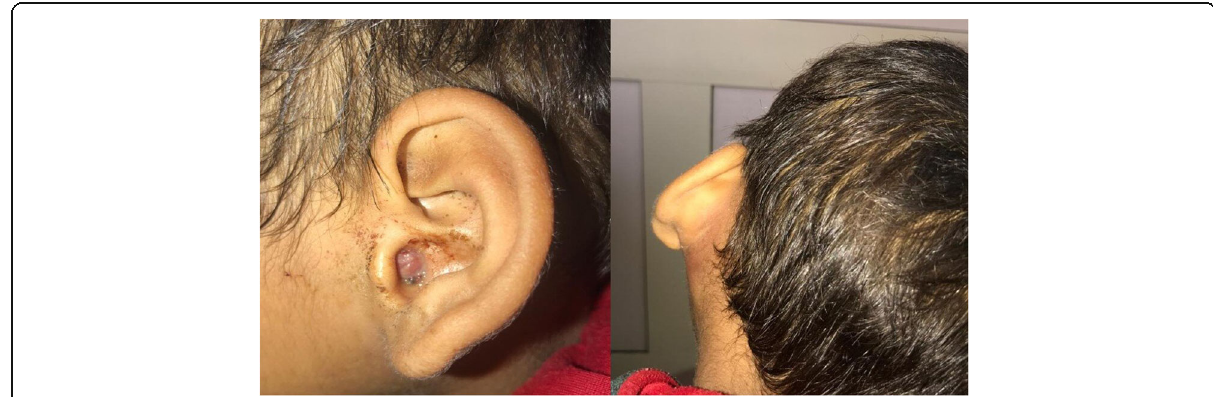
Fig. 1 On the left showing the left middle ear polyp with surrounding active discharge, the right figure shows left post-auricular and parotid swelling elevating the